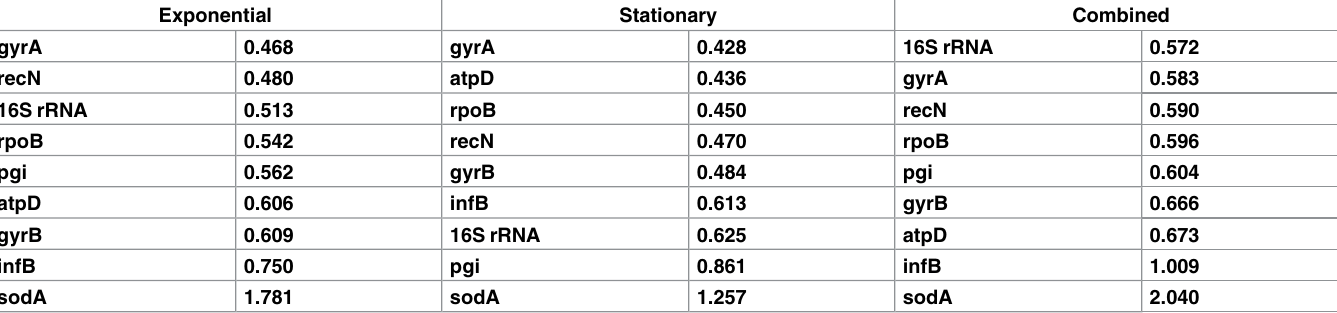
Table 2. Gene expressionstability rankings for different growth phase in A . paragallinarum serovarA analyzed by geNorm. Exponential